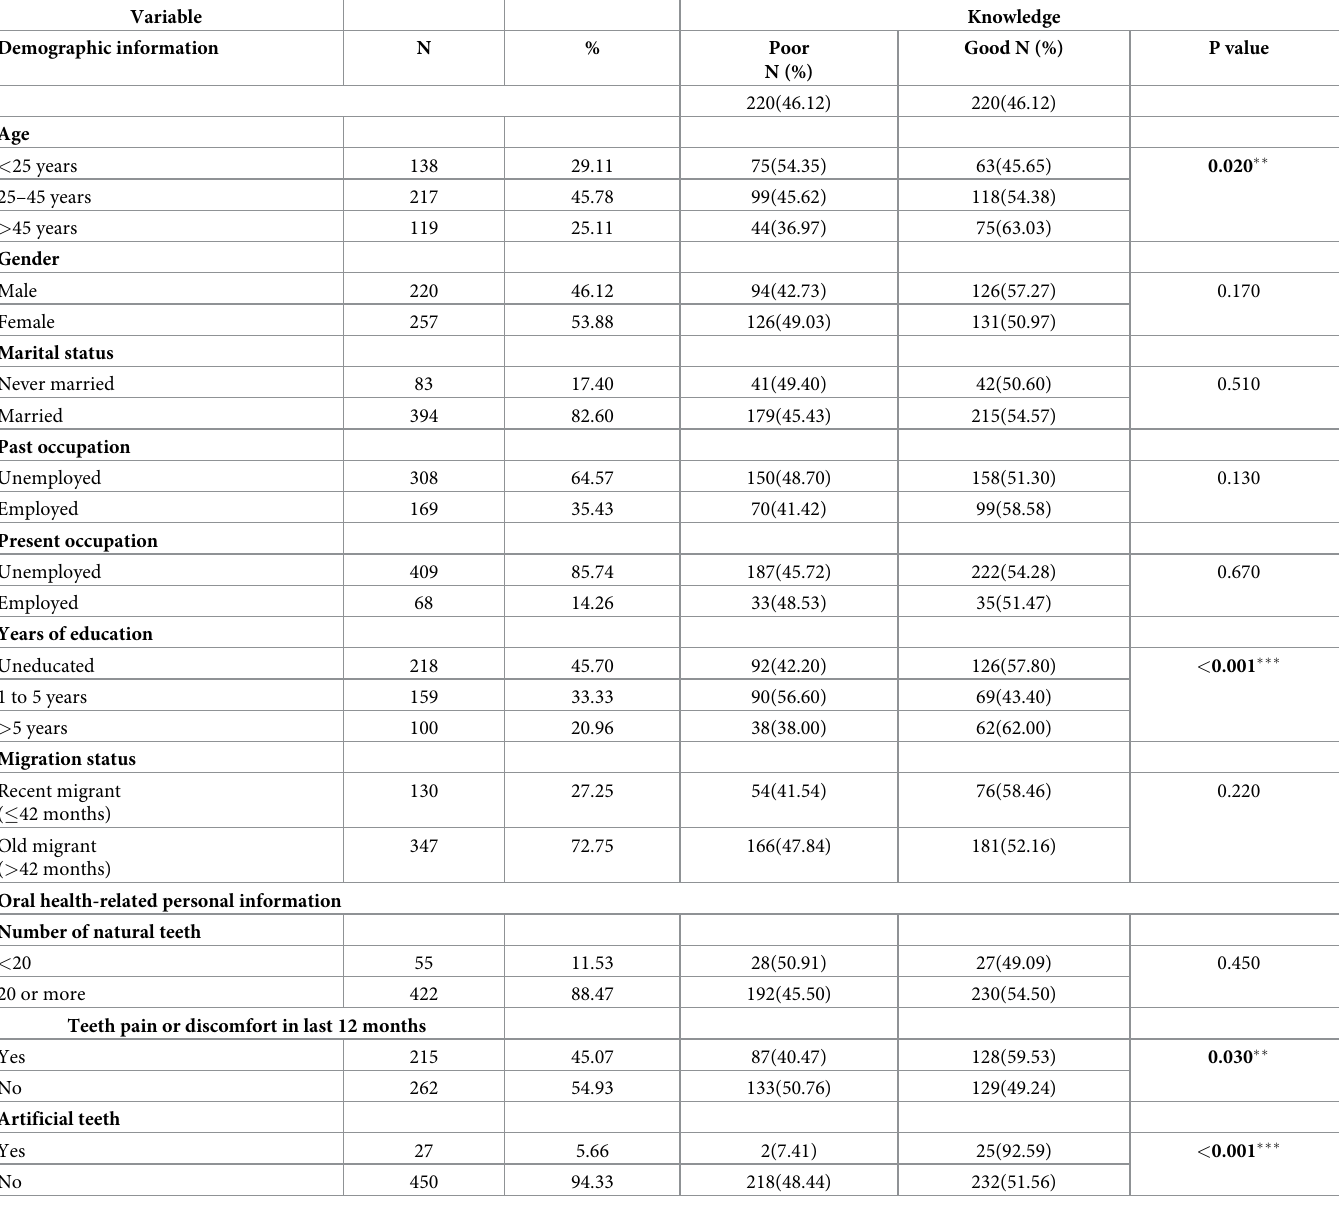
Table 1. Demographic characteristics of the participants and its association with oral health knowledge (N =